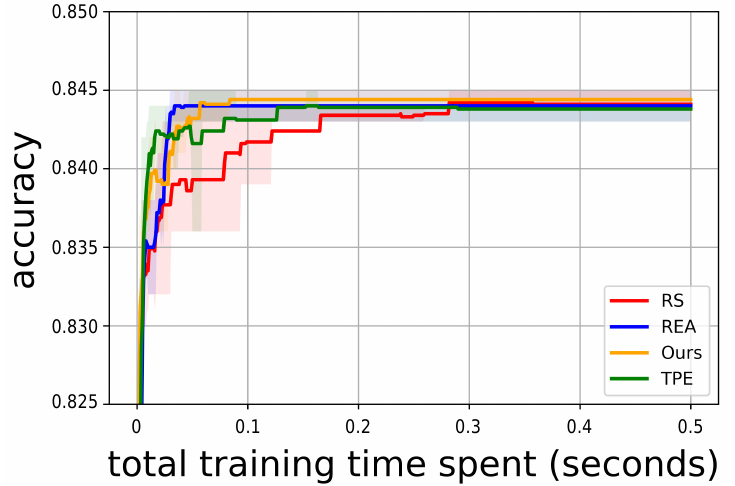
Figure 6. A Comparison of the mean test regret performance of 500 independent runs as a function of estimated training time for NAS-Bench-201 on Cifar10